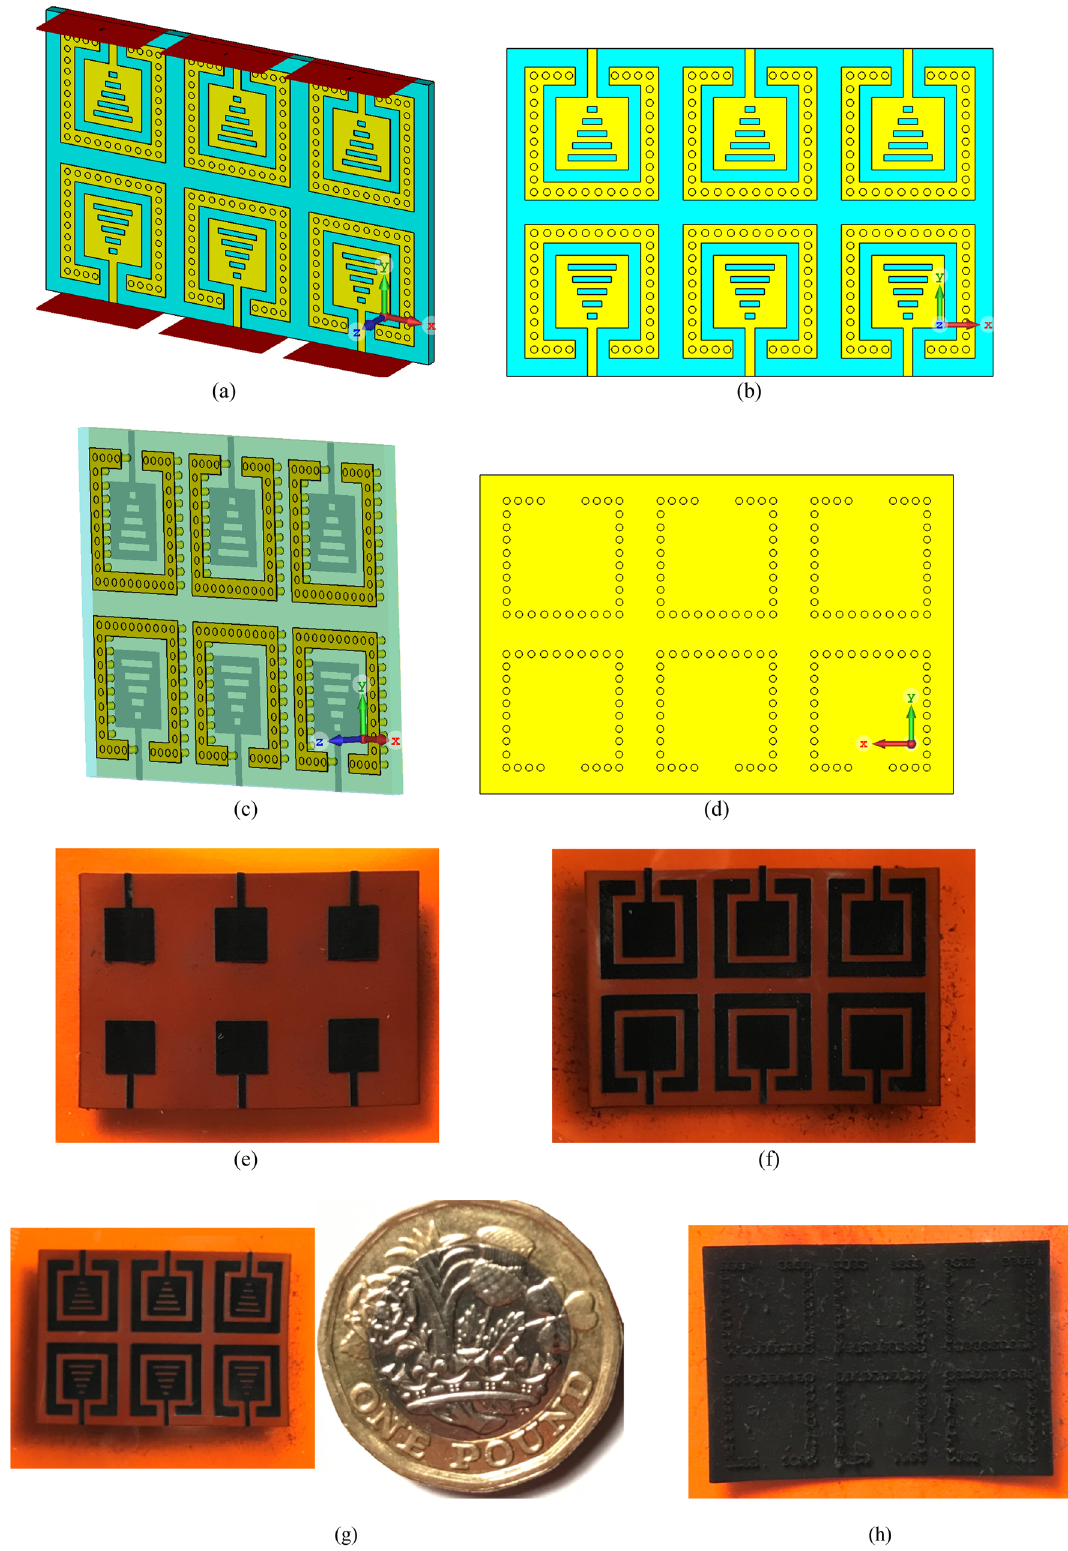
Figure 12. Proposed Graphene coated 2 × 3 antenna array based on SIW-loaded MTM patches, ( a ) isometric view, ( b ) front view, ( c ) SIW isolators framing the radiation patches, ( d ) back view (ground-plane), and ( e – h ) the fabricated antenna array prototype of the reference, SIW-loaded, SIW-loaded MTM antenna, and the ground-plane,